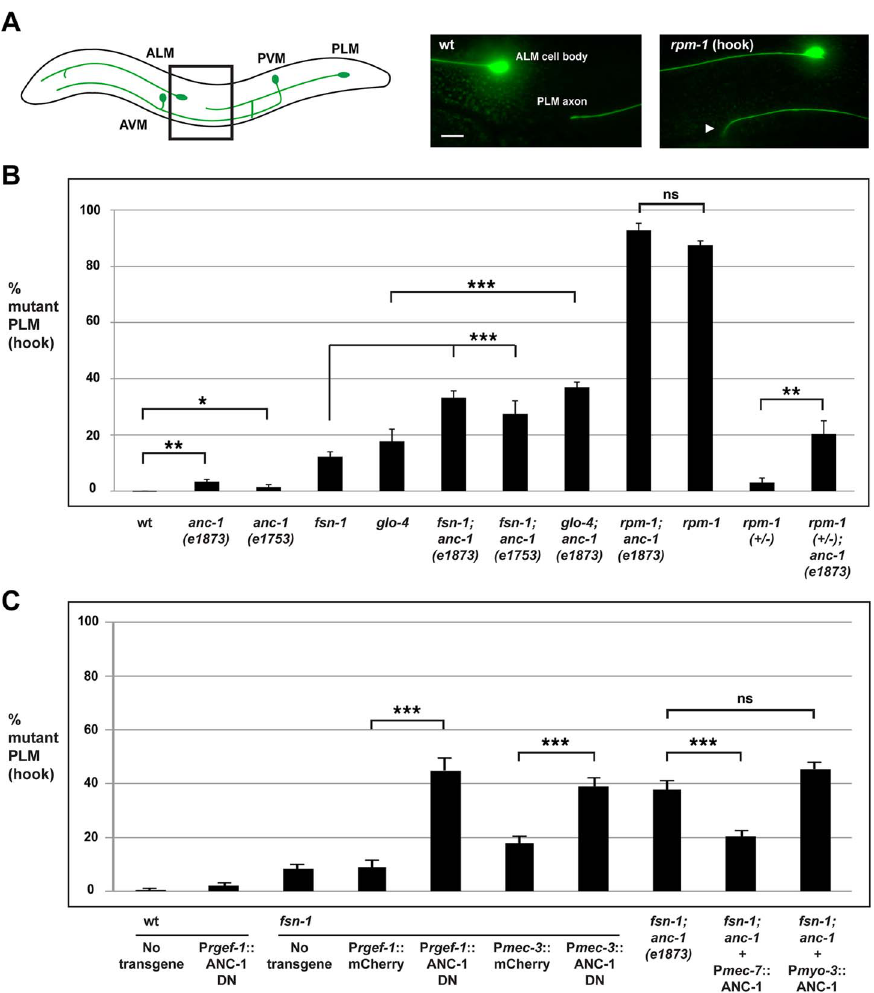
Figure 4. anc-1 functions cell autonomously to regulate axon termination in the PLM mechanosensory neurons. (A) Upper panel diagrams the mechanosensory neurons of C. elegans (inspired by Worm Atlas). PLM neurons were visualized using muIs32 [P mec7 GFP]. The black box indicates the region of the animal that is visualized by epifluorescent microscopy and shown on the right. Shown for the rpm-1 mutant is the PLM axon termination phenotype that we refer to as a hook defect (arrowhead). Scale bar is 10 m m. (B) Quantitation of axon termination (hook) defects in PLM neurons for the indicated genotypes. (C) An ANC-1 dominant negative construct (ANC-1 DN) was expressed using a pan-neuronal promoter (P rgef-1 ) or a mechanosensory neuron specific promoter (P mec-3 ) with the indicated genotypes. A full length ANC-1 rescue construct (P mec-7 ::ANC-1) was expressed in anc-1; fsn-1 double mutants. The data shown is an average of 5 or more transgenic lines for each genotype. Analysis was done on young adults grown at 23 u C. Significance was determined using an unpaired Student’s t test; error bars represent the standard error of the mean. * P , 0.05, ** P , 0.01, *** P , 0.001, ns=not significant.